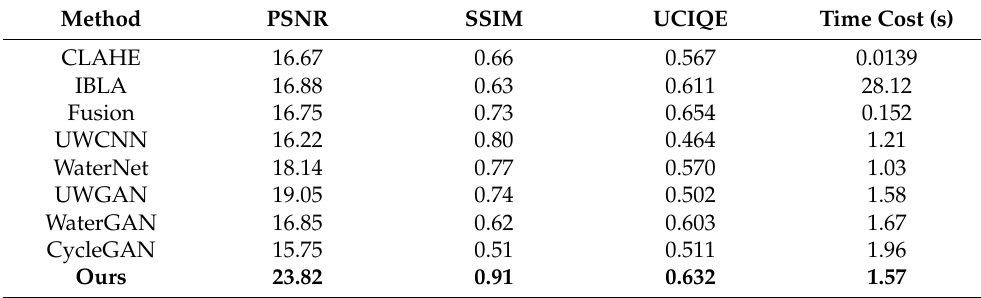
Table 3. Quantitative comparison of the enhanced performance on the UIEB datasets.